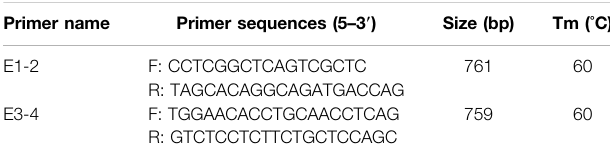
TABLE 1 | Primer information of SSTR5 of Hulun Buir